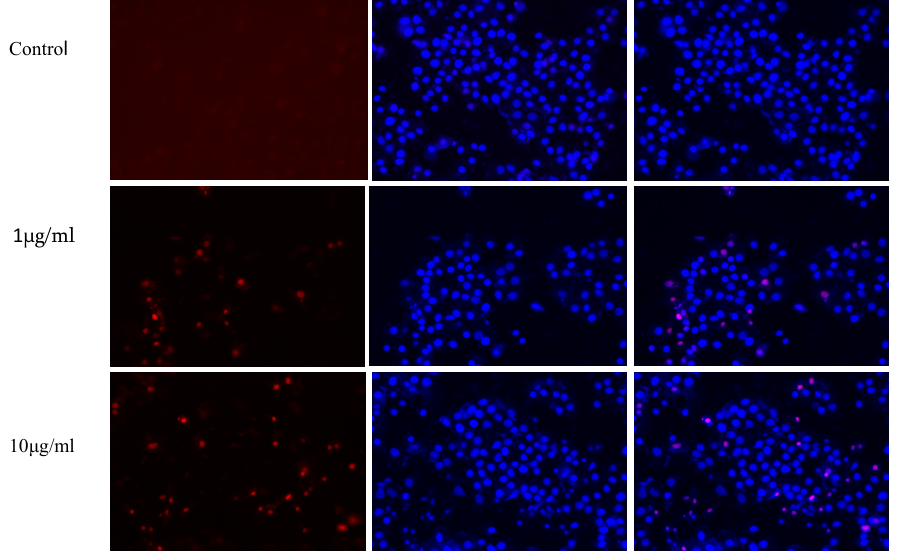
Figure 11. Dual staining of KB cells with Hoechst (blue colour) and PI (red colour) upon 24 h exposure to different concentrations of nanocomposite. Control cells exhibited no dual staining and in the treated cells, the number of dead cells increases while increasing the concentration. Propidium Iodide-stained cells were observed in red fluorescence and Hoechst-stained cells were observed under blue fluorescence. Combined images showed that apoptosis of the cells was increased with the increase in nanocomposite concentra- tion that was indicated by the increased pink (combined) color fluorescence intensity. 4. Conclusions In the current study, we examined the extrusion, injection molding, and plas- tics-processing processes used to create polymer nanocomposites and evaluated their mechanical and cytotoxic properties. The PMMA/OH-MWCNT composite leads to apoptosis induction in the malignant KB cells in the dose-dependent manners. The main findings of the investigations conducted and discussed in this article may inspire fresher concepts for improving cancer treatment through composite materials disease. The same technology was used to test a variety of polymer combinations, but due to non-homogeneous mixing, the ones stated above are replacing traditional drug delivery systems due to their important advantages, such as minimal harm to healthy cells and a lack of side effects. For cancer treatments, applying external or internal stimulation is strongly advised. They are a strong impulse for the continuation of research in this area. As a result, we can conclude that MWCNT-reinforced PMMA has the potential to inhibit the growth of cervical cancer cells. This material can now be further explored in order to reveal its full anticancer potential. Author Contributions: Conceptualization: V.P., U.J., A.J. and T.K.U.; Data curation: Mechanical Data, V.P., U.J. and A.J., Biological activity data, T.K.U.; Formal analysis, Mechanical-V.P., U.J. and A.J., Biomedical-T.K.U.; Funding acquisition: L.A.A., N.A. and M.S.; Supervision, U.J. and A.J.; Writing—original draft: V.P., U.J., A.J. and T.K.U.; Writing—review and editing V.P., U.J., A.J.,